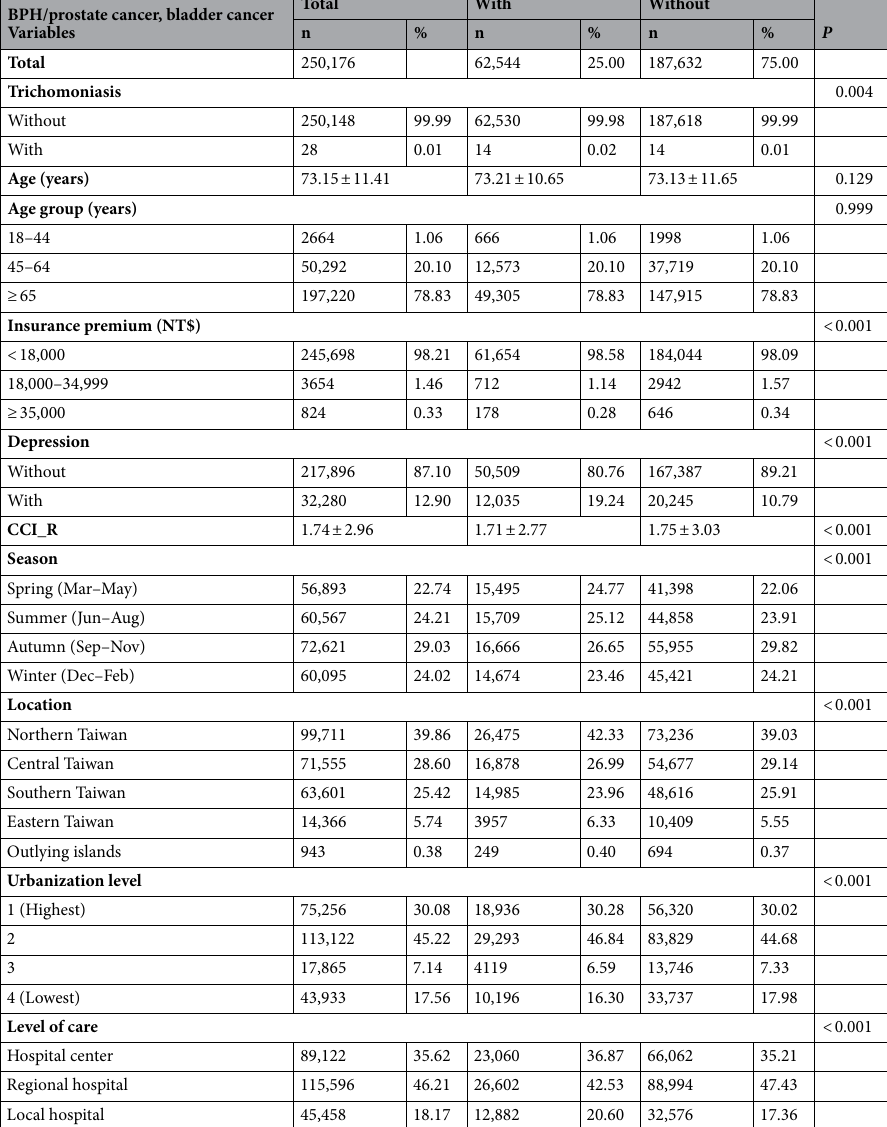
Table 1. Characteristics of the study group. P: Chi-square/Fisher exact test on categorical variables and t test on continue